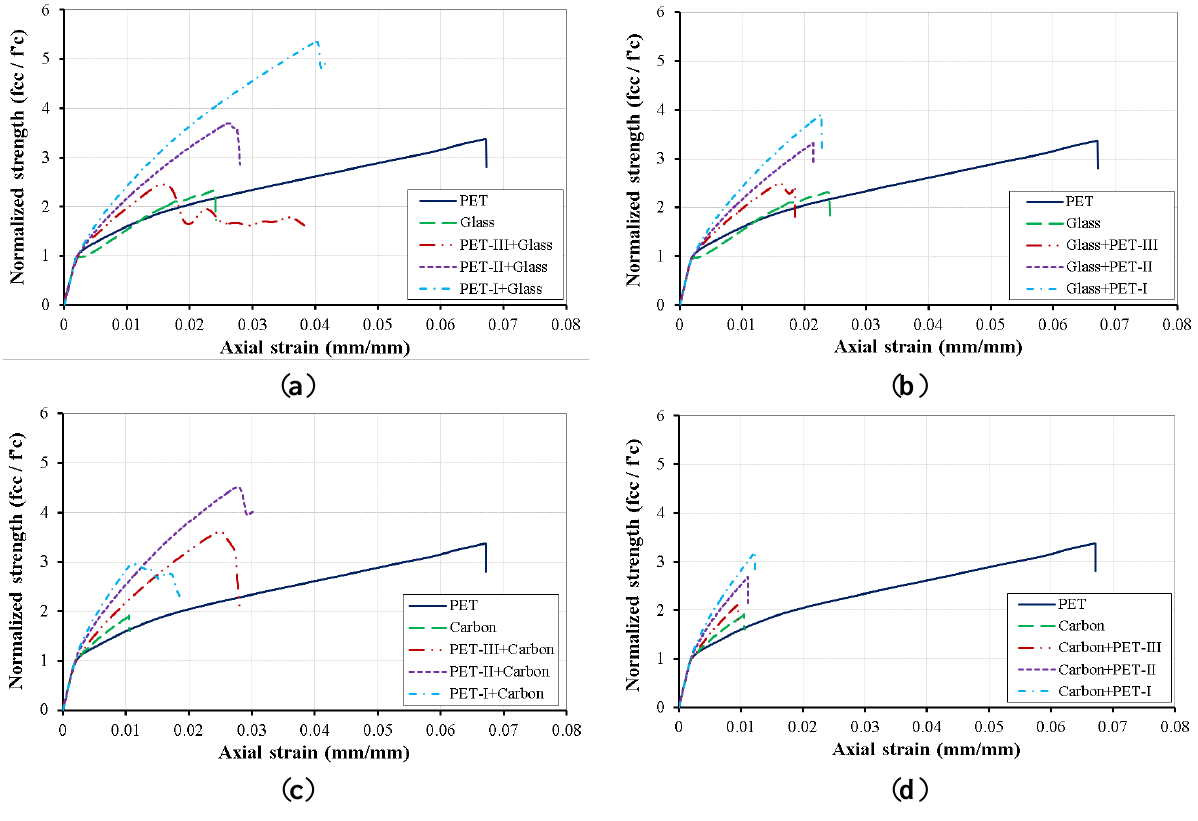
Figure 6. Axial strain-normalized strength relationship of the traditional, LRS, and hybrid FRP: ( a ) PET/Glass-FRP; ( b ) Glass/PET; ( c ) PET/Carbon-FRP; and ( d )